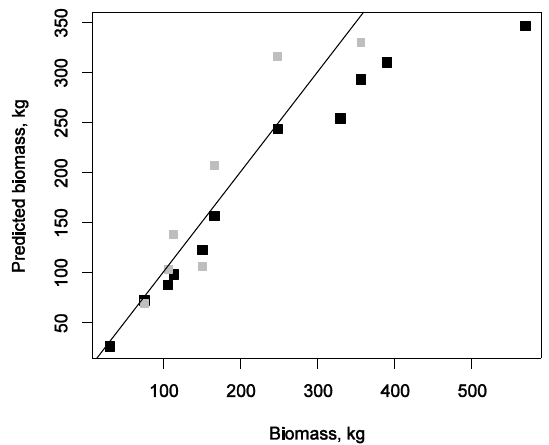
Figure 6. Field measured vs. predicted biomasses for spruces. Predicted by models (Repola 2009, black) and TLS (grey).